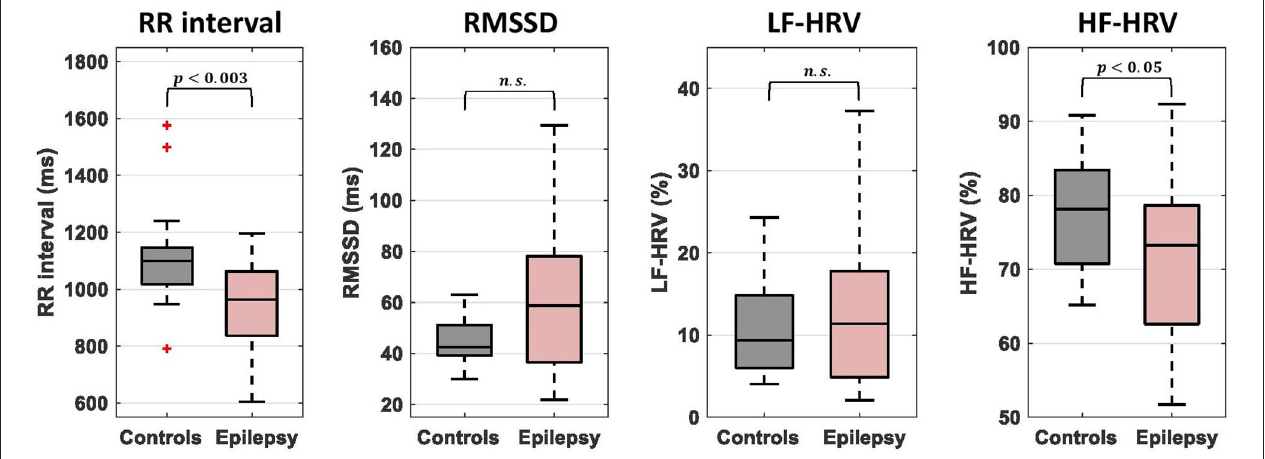
FIGURE 1 | Comparison of mean RR interval and heart rate variability (HRV) measures between epilepsy patients and healthy controls. The bottom and top of each box correspond to the 25th and 75th percentiles of the sample distribution, the line in the box corresponds to the median and the crosses indicate outliers, defined as values that are more than 1.5 times the interquartile range away from the edges of the box. The epilepsy patients showed significantly lower values of mean RR interval and HR-HRV than healthy controls. n.s., not significant.